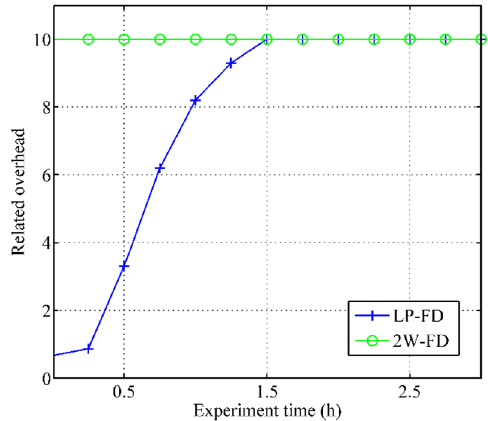
Figure 7. Comparison of related overhead.